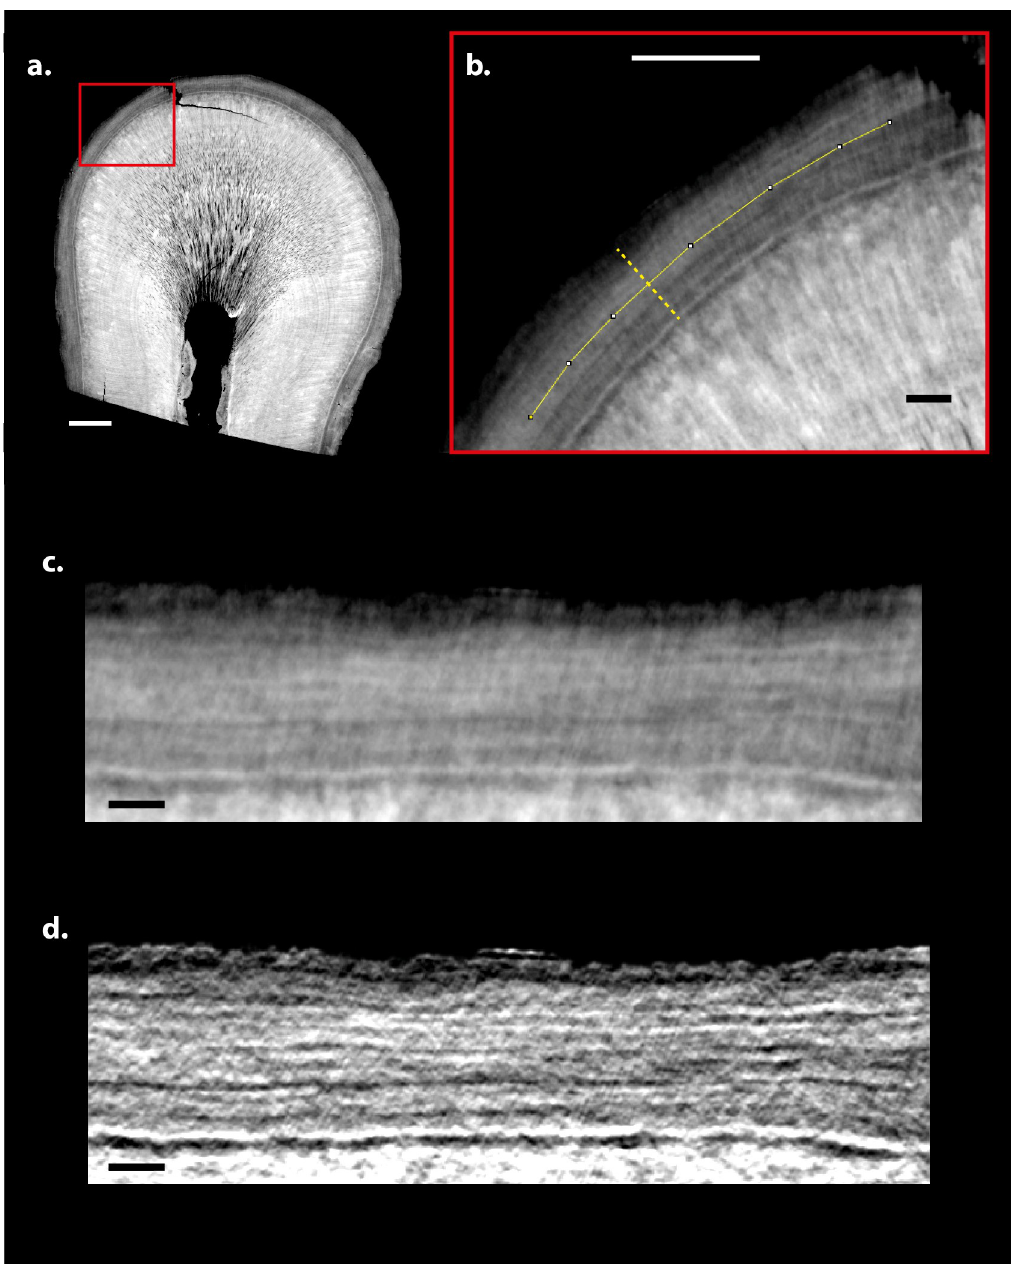
Fig 5. Image processing of PPCI SR CT images of Macaca mulatta cementum. ( a ) One CT slice of specimen l59. ( b ) Detail of CT slice highlighting circumferential cementum increments (cementum defined by dashed yellow line) with midline shown as solid yellow line. ( c ) Straightened cementum section following the midline highlighted in ( b ). ( d ) Filtered image of ( c ) using a steerable Gaussian filter (see Section 1 in S1 File. ‘Image processing by directional filtering’). White scale bar in ( a ) represents 200 μ m; and in ( b ) represents 100 μ m. Black scale bars in ( c ) and ( d ) represent 30 μ m.